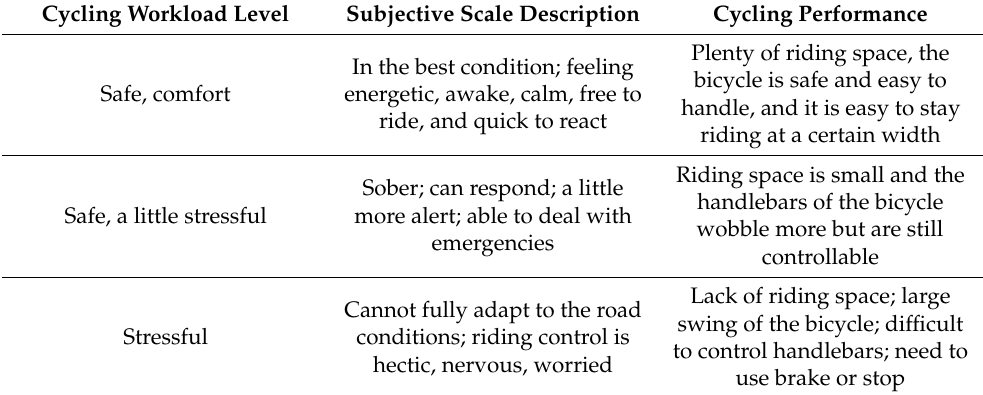
Table 1. Subjective scale for the cycling workload level. Cycling Workload Level Subjective Scale Description Cycling Performance